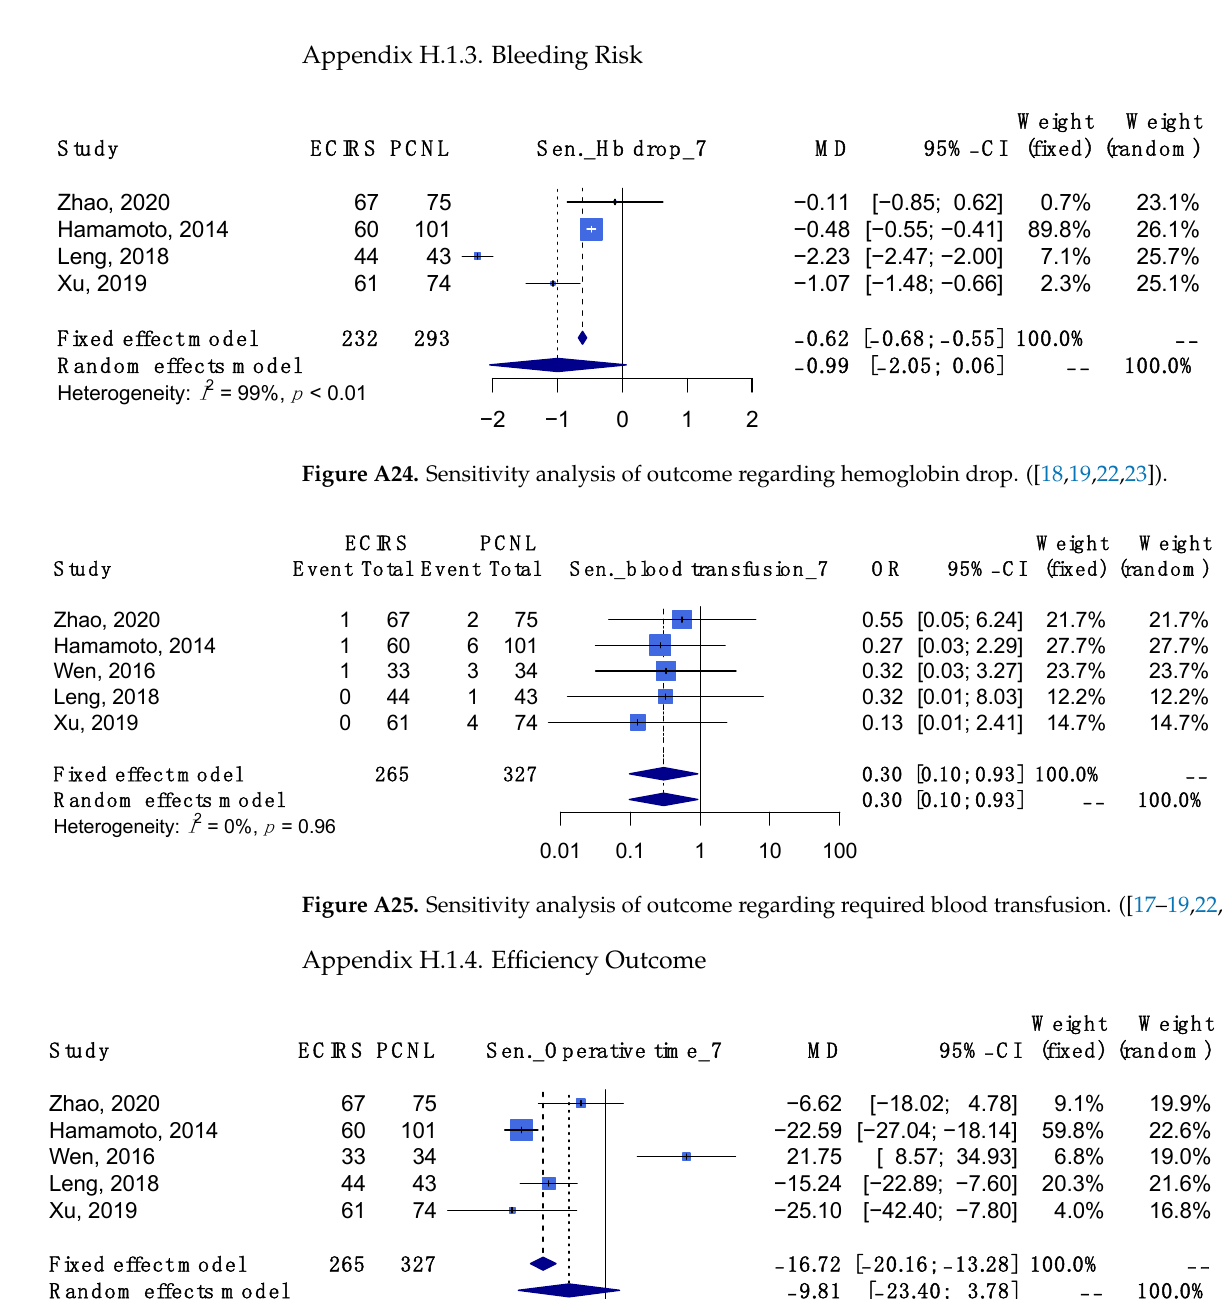
Figure A23. Sensitivity analysis of outcome regarding post-operative fever. ([17–19,22,23])